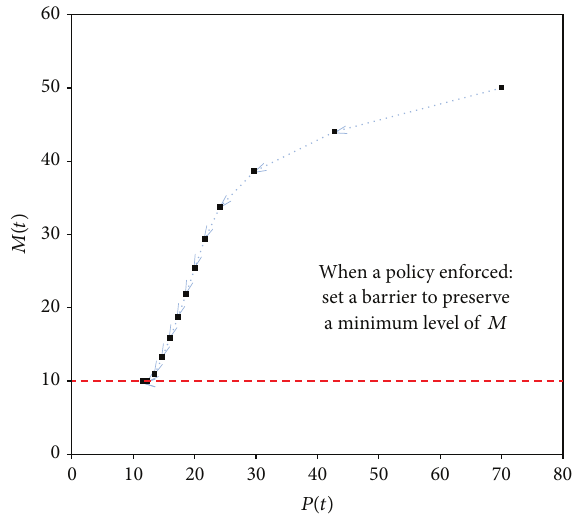
Figure 5: Experimental example, with a barrier to sustain the market. Here, all the parameters and the initial states remain the same as the ones in Figure 2 (but the axes have been scaled differently). In addition, however, there is a barrier set up for the market maturity. This barrier keeps the market maturity factor 𝑀(𝑡) above 10. Arrows show the directions of the migration of the system state, which settles down to a fixed state, of which 𝑀(𝑡) corresponds to the barrier. In this instance, there is no